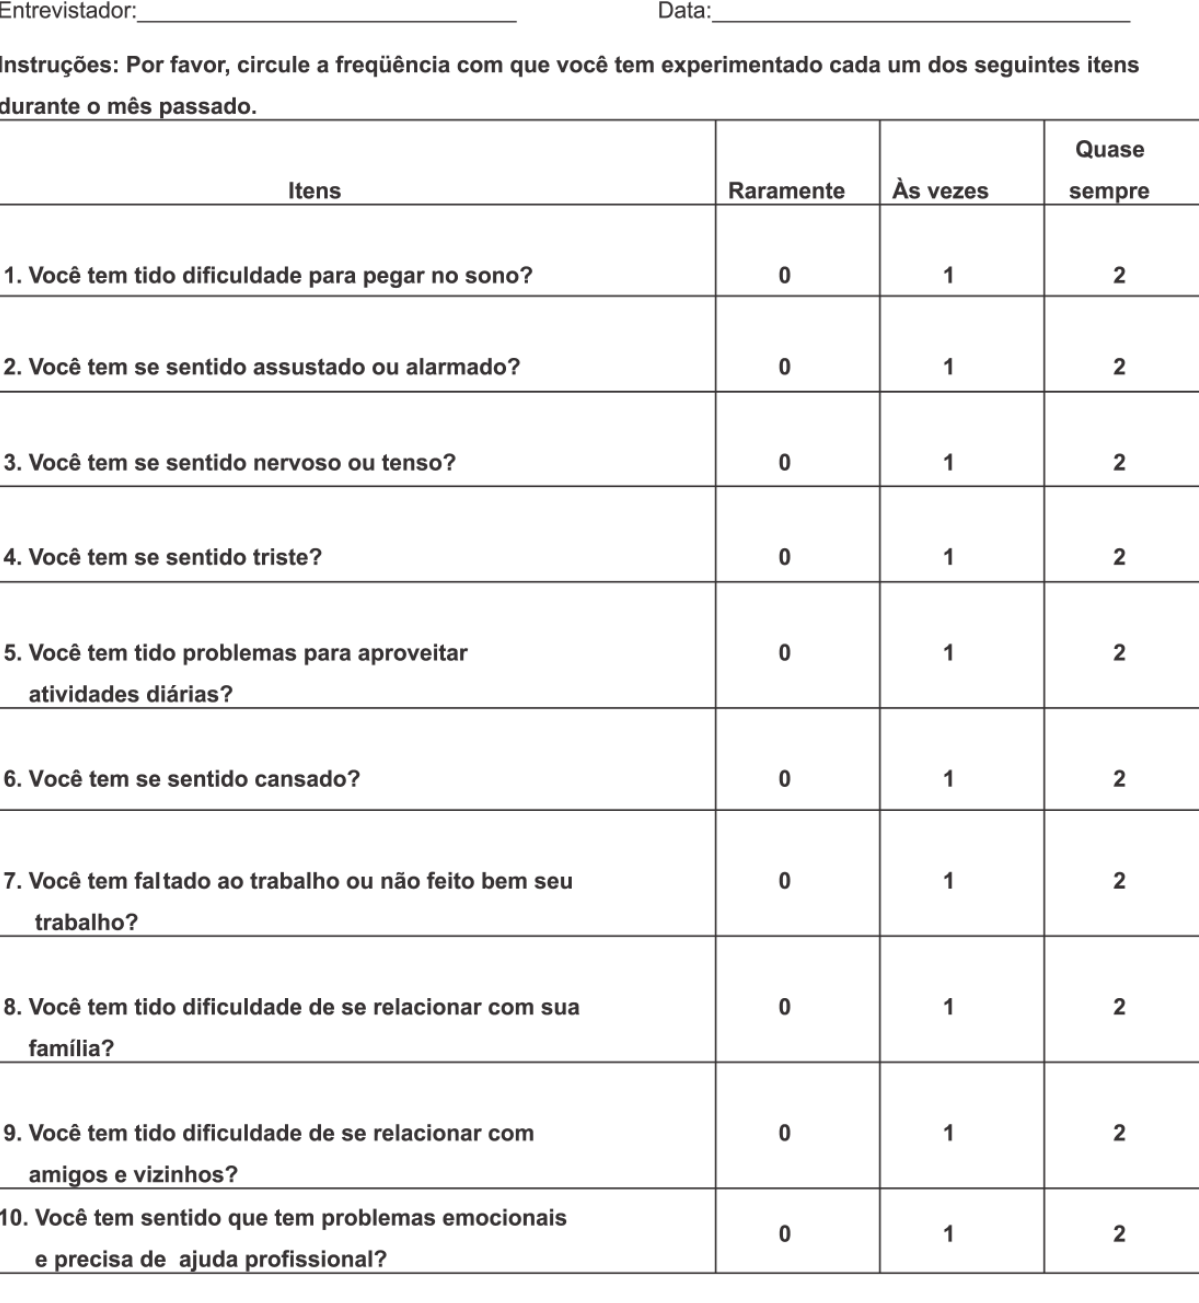
Figure 1 – The Portuguese Version of the Personal Health